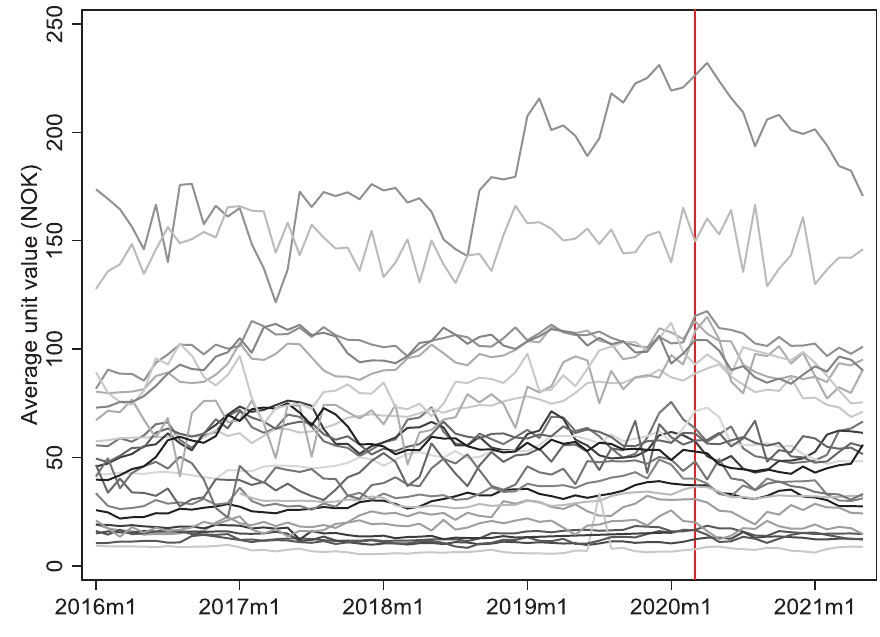
Fig. A3. Unit value. All